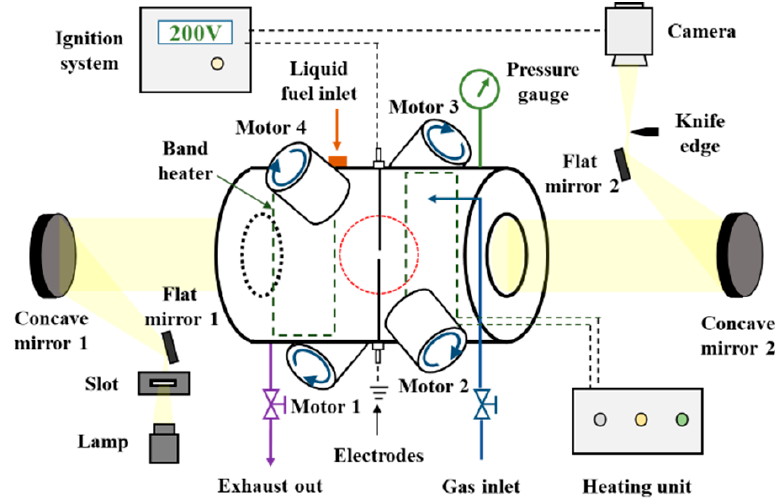
Figure 1. Diagram of the fan-stirred, constant-volume bomb apparatus.